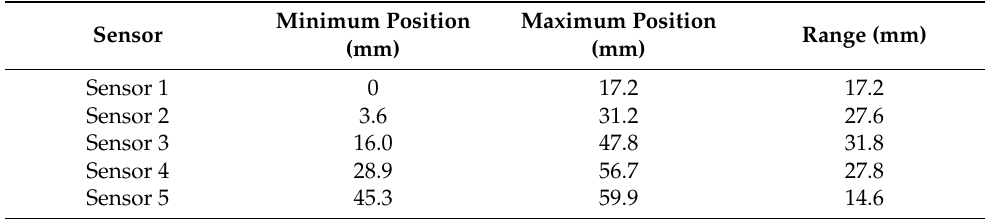
Table 2. Position of the linear shaft where each sensor reaches its minimum value from the output and its reference voltage.